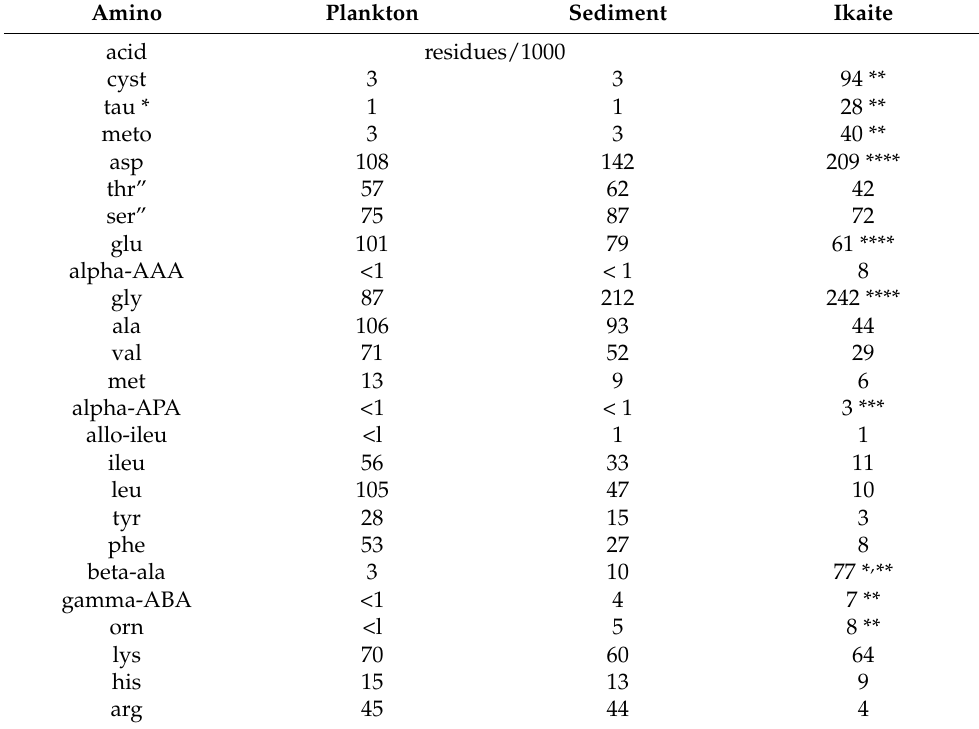
arg Concentrations in µ g/g; * complex mixture with taurine; ** degradation products: beta-ala from aspartic acid tau- rine, cysteic acid from cysteine and methionine, gamma-ABA from glutamic acid, ornithine from arginine, and/or bacterial biomass: alpha-DPA and alpha-AAA; *** beta-ala: here very likely from degradation of aspartic acid; **** amino acids in Ca-carbonate-secreting organic templates; amino acids of silica-secreting tissue concentrated in Bransfield Strait